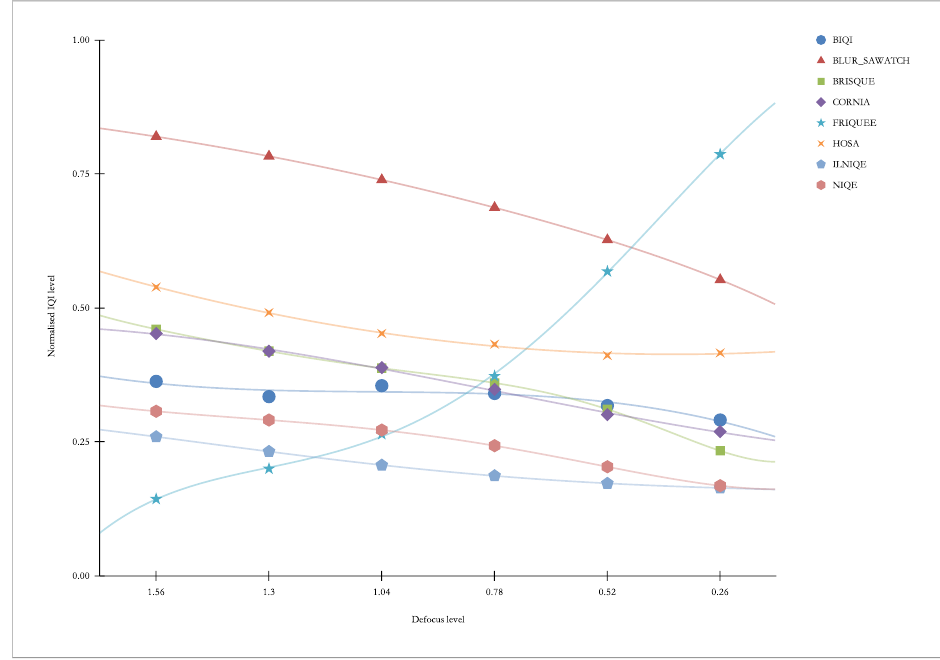
Figure 16. “Other” indicators vs. Defocus [ σ